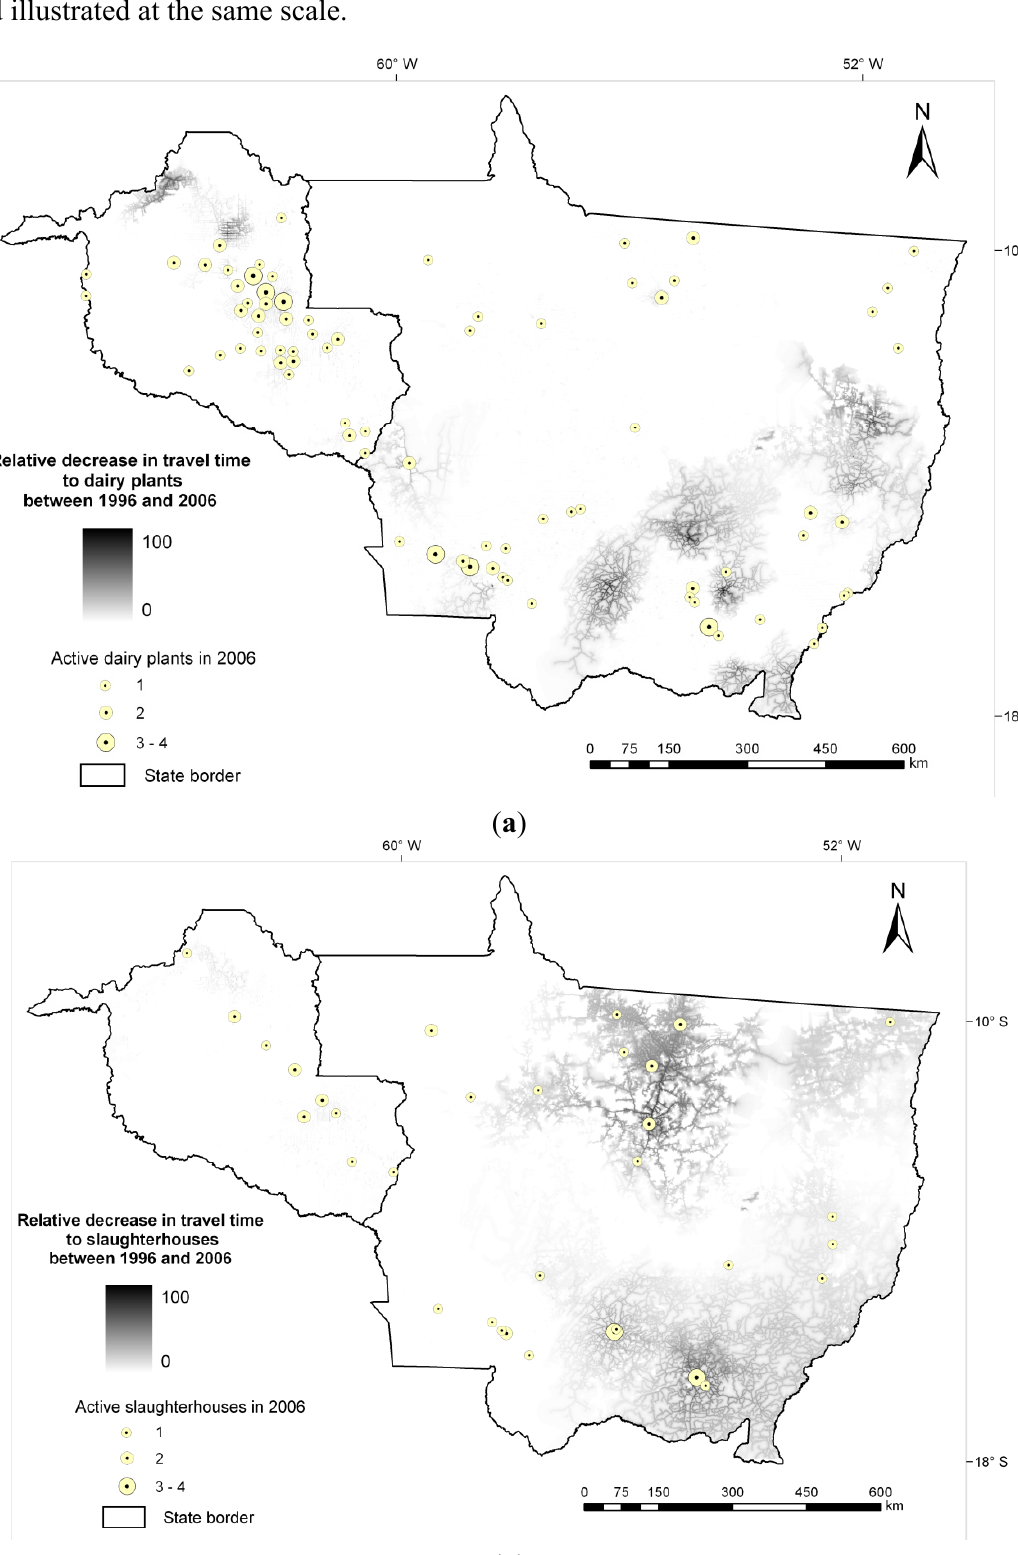
Figure 2. Changes in travel time to: ( a ) dairy plants; ( b ) slaughterhouses, given as the percentage decrease in travel time to market facilities between 1996 and 2006 relative to the 1996 travel time. Changes are calculated separately for Rondônia and Mato Grosso and illustrated at the same